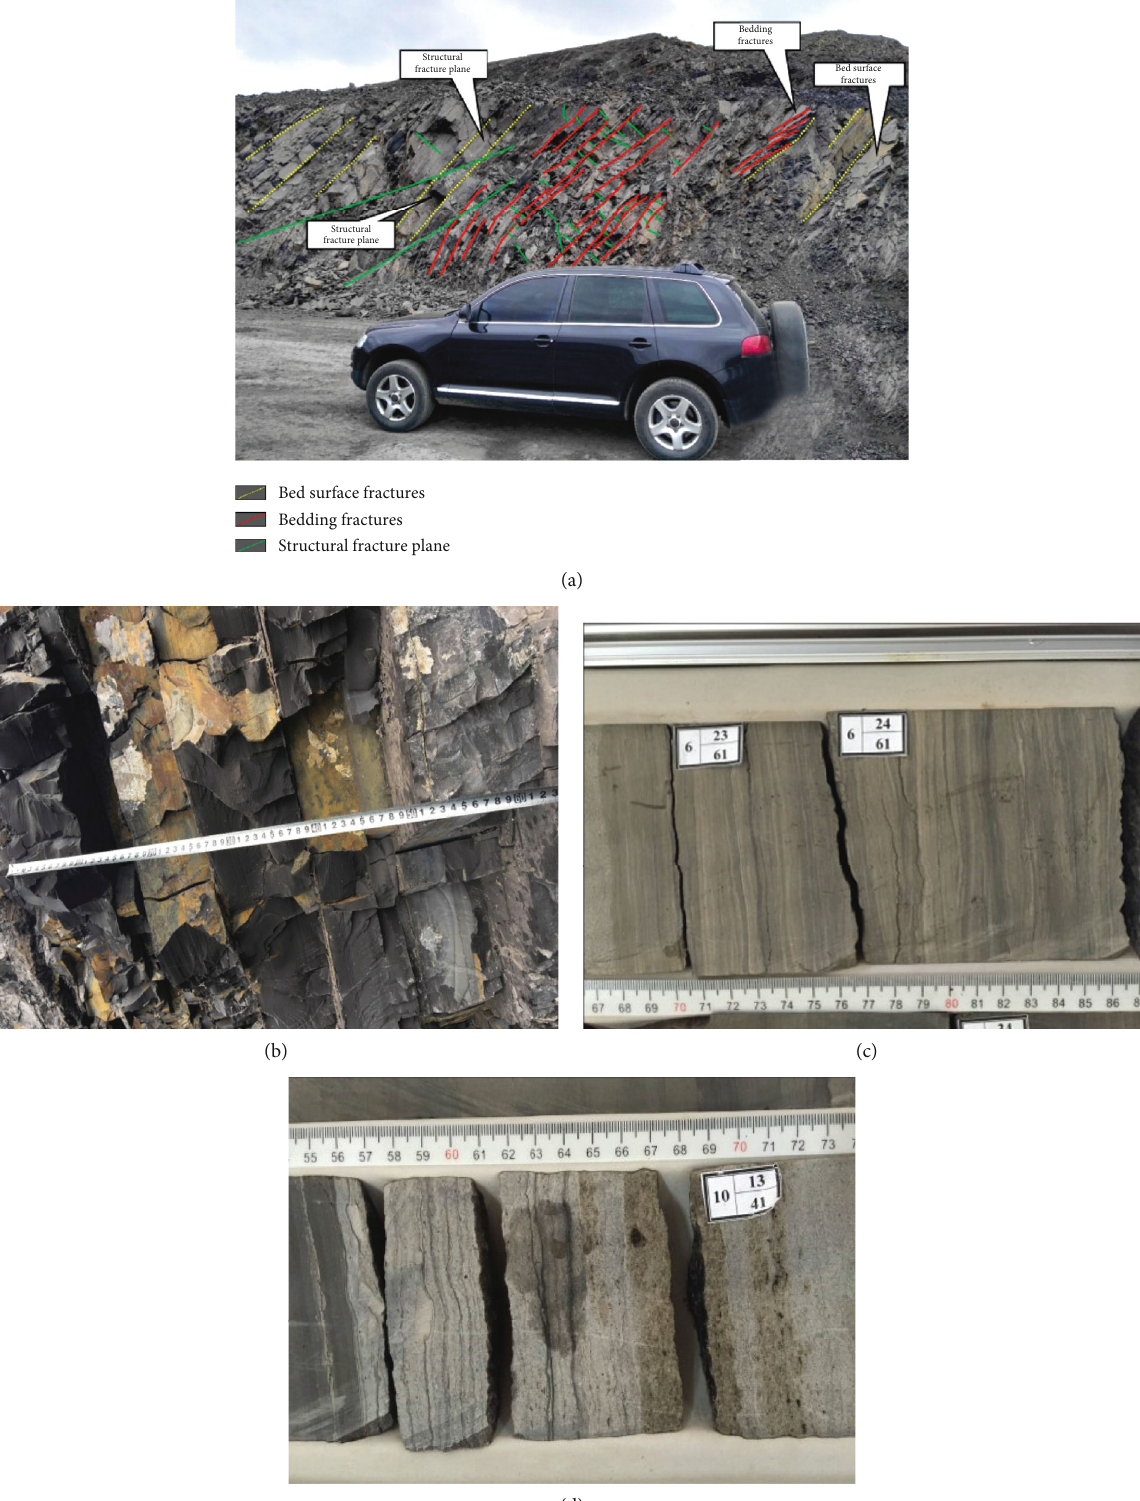
Figure 3: (a) Macroscopic photograph of Lucaogou outcrop 10km southeast of Santao town of Jimsar county, Xinjiang; (b) local photograph of Lucaogou outcrop 10km southeast of Santai town of Jimsar county, Xinjiang; (c, d) core photographs of bedding fractures in Lucaogou formation, Jimsar